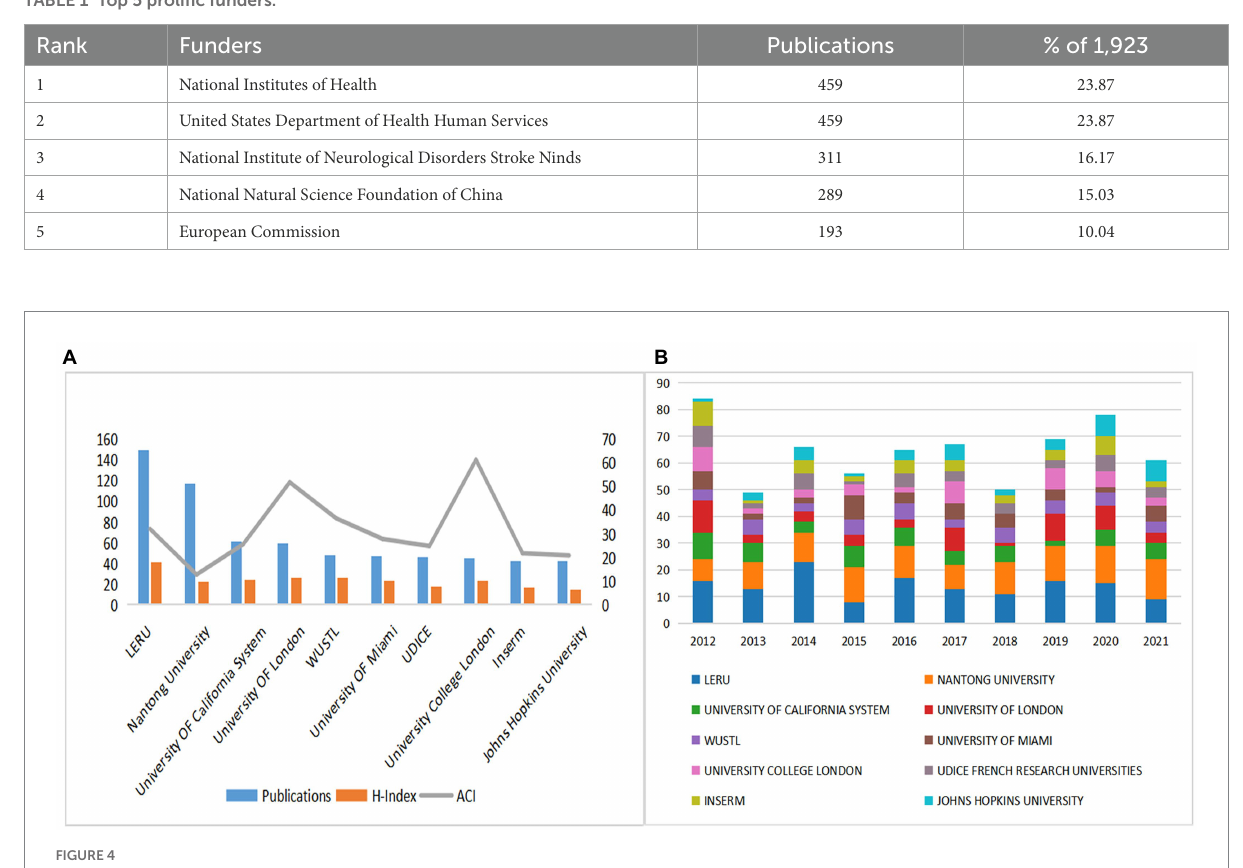
FIGURE 4 (A) The publications, H-indexes, and ACIs of the top 10 most prolific institutions. (B) The publications of the top 10 most prolific institutions each